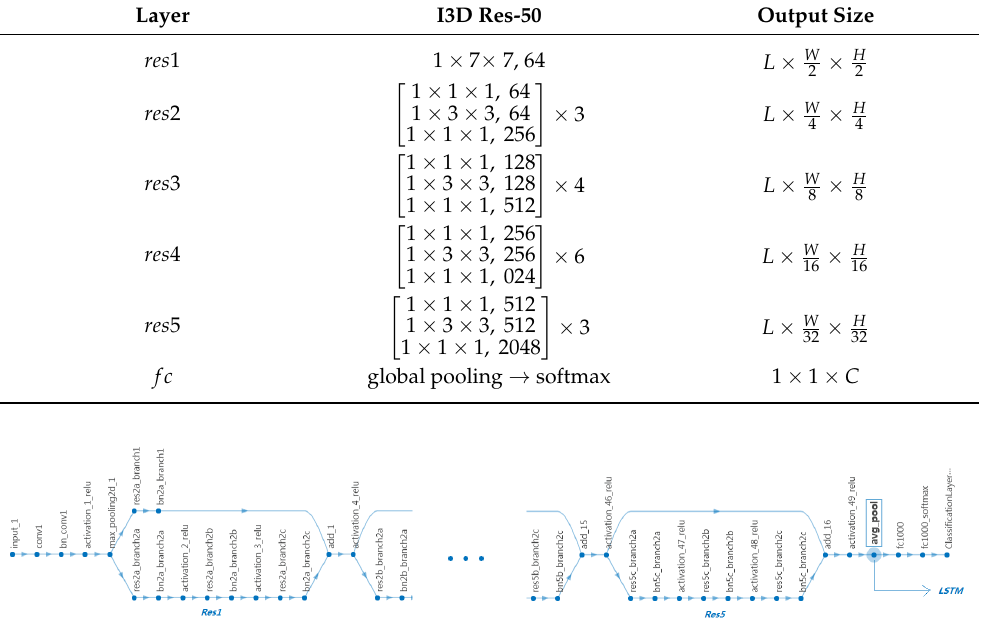
dimension C of the last fully connected layer is equal to the number of classes in the target dataset.